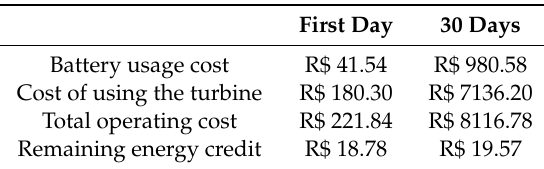
Table 3. Operating data for scenario